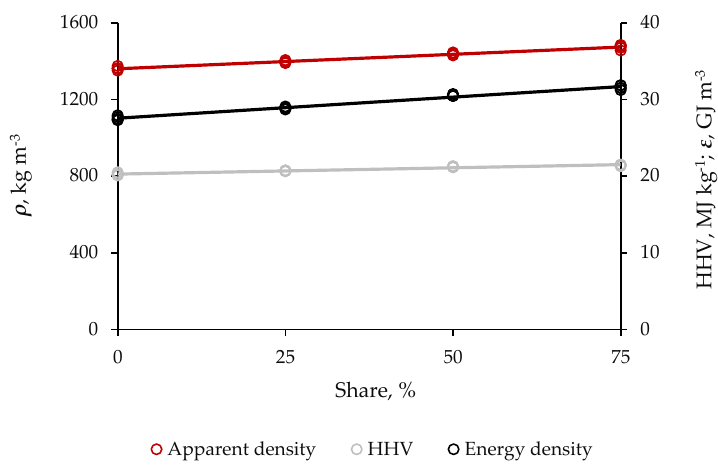
Figure 3. Effect of share of residual biomass from distillation of cellulosic bioethanol in the blend with sugarcane bagasse on the physicothermal quality of hybrid non-wood pellets. The steeper the line is, the larger the probability of the factor becoming the cause of significant variability is, as it gains in linearity; apparent density ( ρ ), higher heating value, (HHV) and energy density ( ε